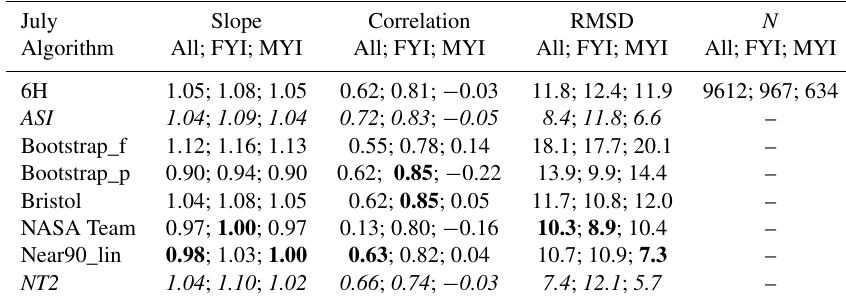
Figure 4. AMSR-E sea-ice concentration computed with six of the eight algorithms listed in Table 2 vs. MODIS sea-ice concentration for all grid cells with MODIS sea-ice concentration > 20% and cloud fraction < 5%. Gray and black symbols denote data from the entire period and July only, respectively. The black line denotes a linear regression of the sea-ice concentrations of July forced through ( 0 , 0 ) with the slope as given in each image. The linear correlation coefficient and root mean square difference for sea-ice concentrations of July are denoted by “Corr.” and “RMSD”. Slope, Corr, and RMSD for June, July (this figure), and August are summarized in Tables 5–7. Table 6. Statistical parameters of the comparison AMSR-E sea-ice concentration vs. MODIS sea-ice concentration (see Fig. 4) for July 2009. Each column gives the value for all grid cells with MODIS sea-ice concentration > 20%, the multiyear (MYI) ice grid cells, and the first-year ice (FYI) grid cells (see Sect. 2.4). Slopes closest to 1, highest correlations, and lowest RMSD values are noted in bold font. Values obtained for the ASI and NT2 algorithm are shown for completeness but are in italic